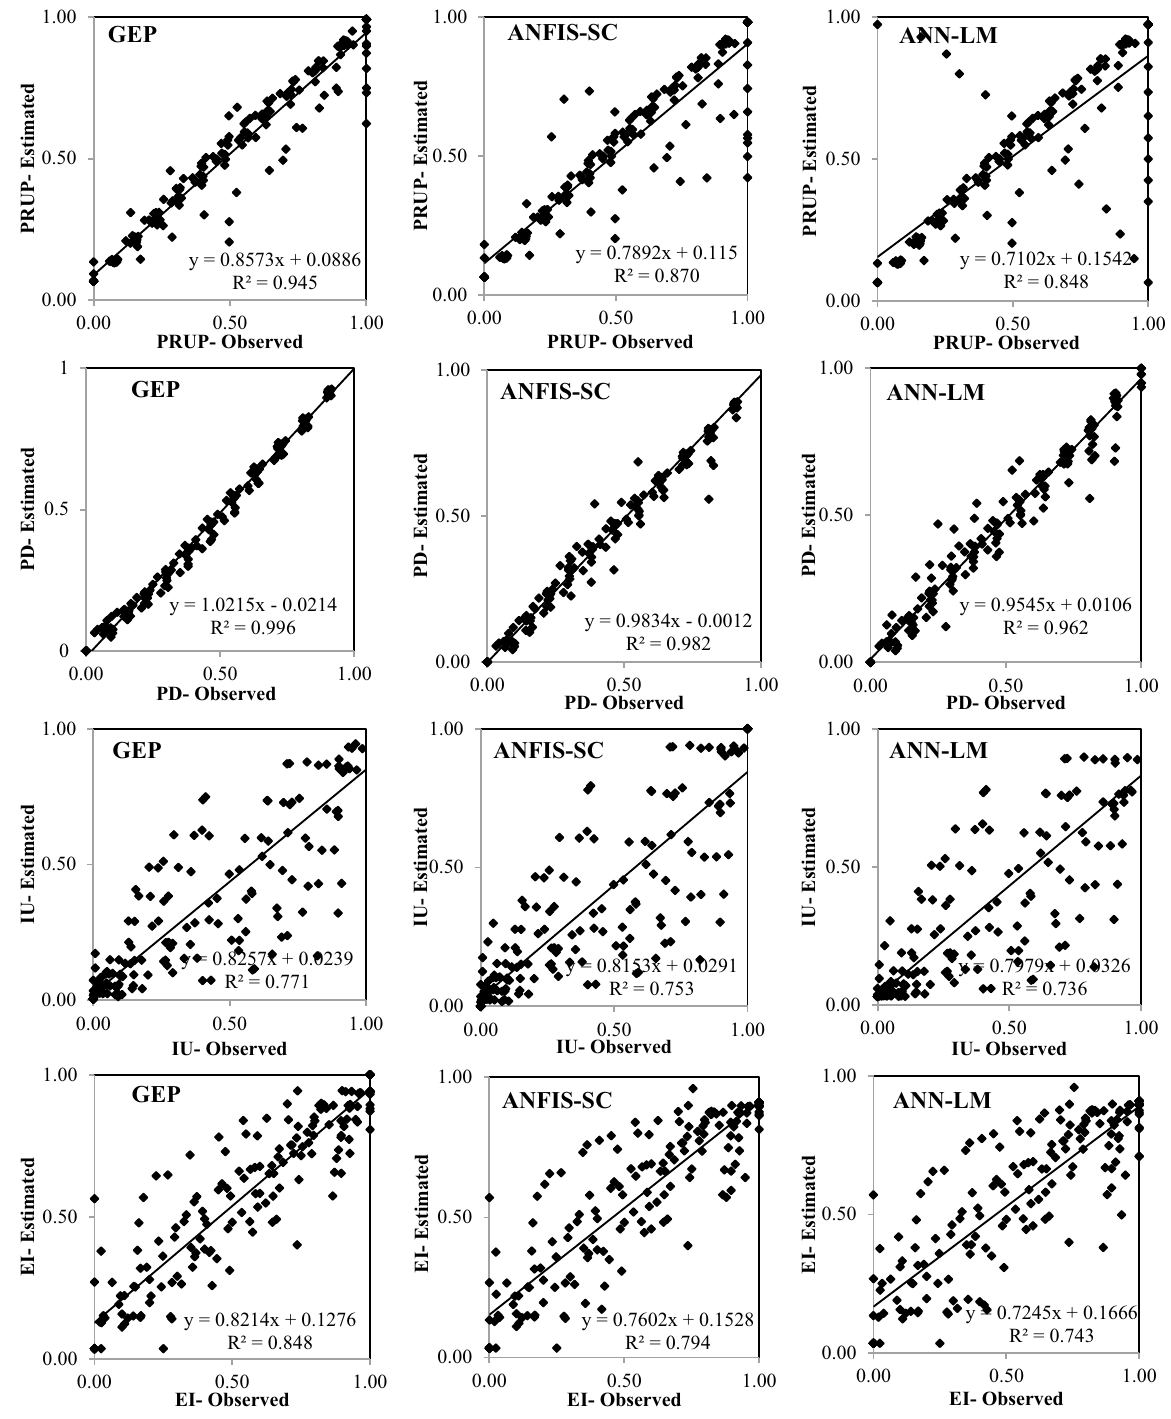
Figure 6. Observed and estimated social parameters during the testing period in